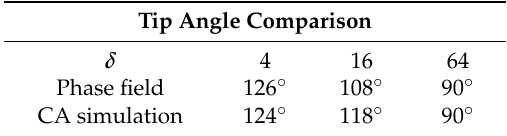
Table 3. Comparison of calculated tip angles with Lin’s phase field model.